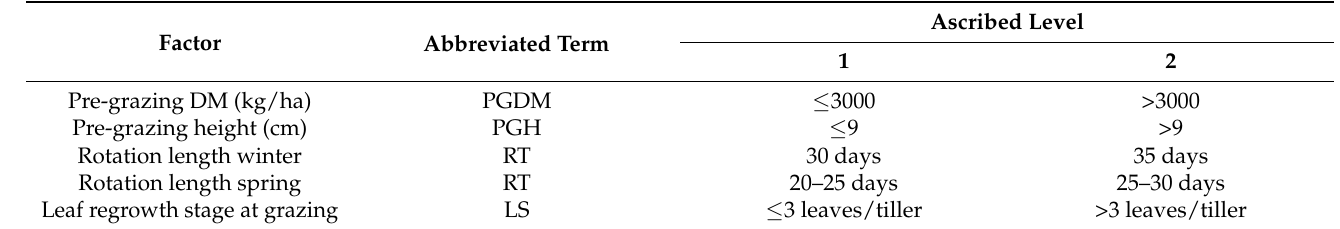
Table 2. The factors used in linear regression models to determine the association between pasture dry matter (DM) and herbage quality